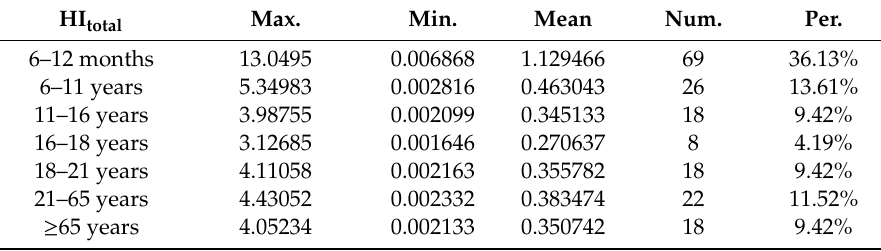
Table 4. The statistical results of non-carcinogenic health risks in the study region.